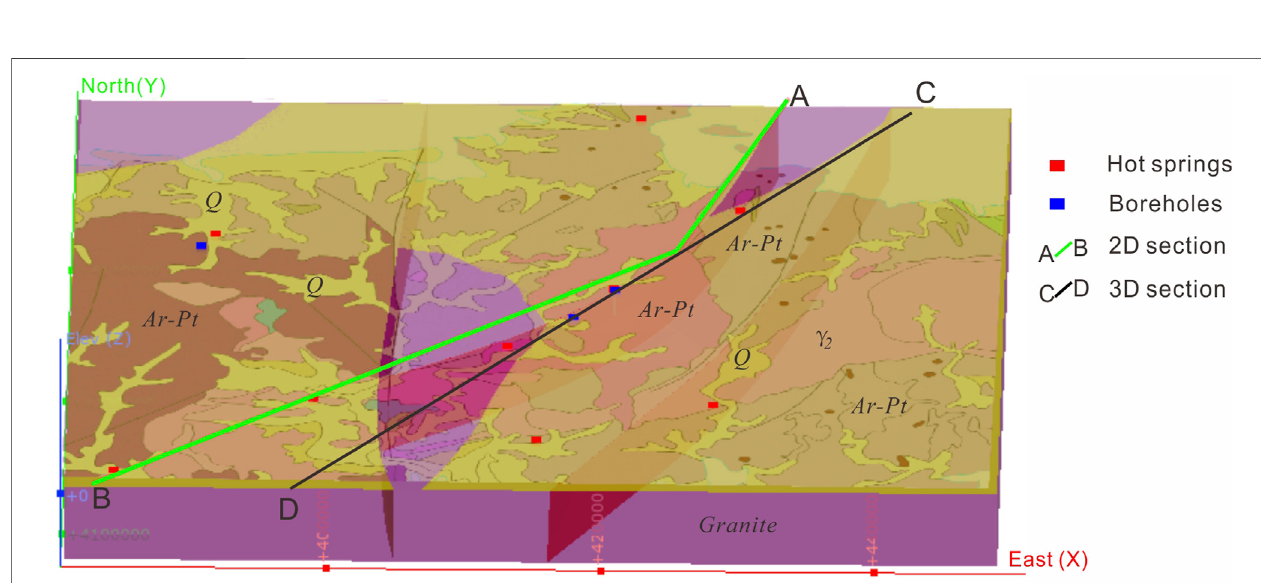
FIGURE 9 | Fracture controlled geothermal conceptual model of the Jiaodong Peninsula.